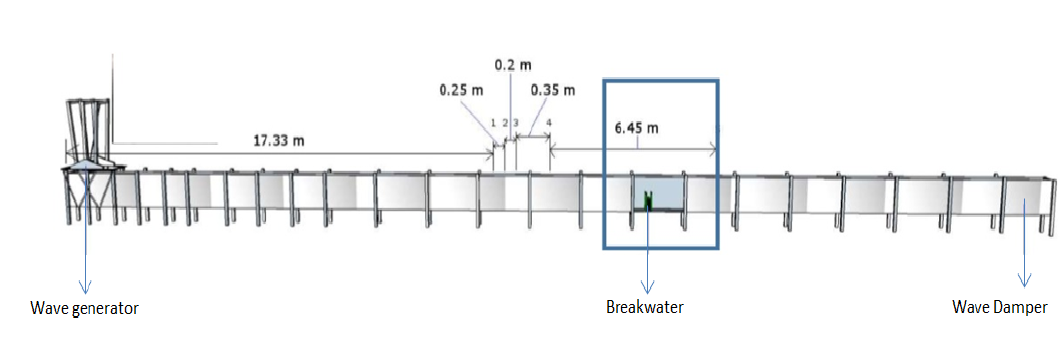
Figure 11. Physical model of the breakwater. Table 3. List of various breakwater size that are used in the experiment. Type